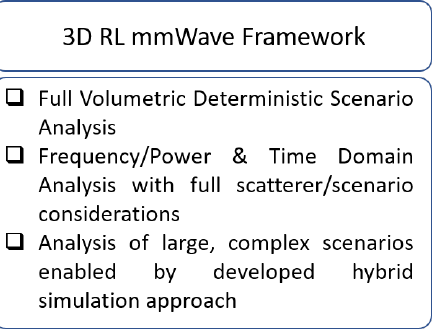
Figure 1. Schematic overview of the main contributions of the 3D-RL mmWave